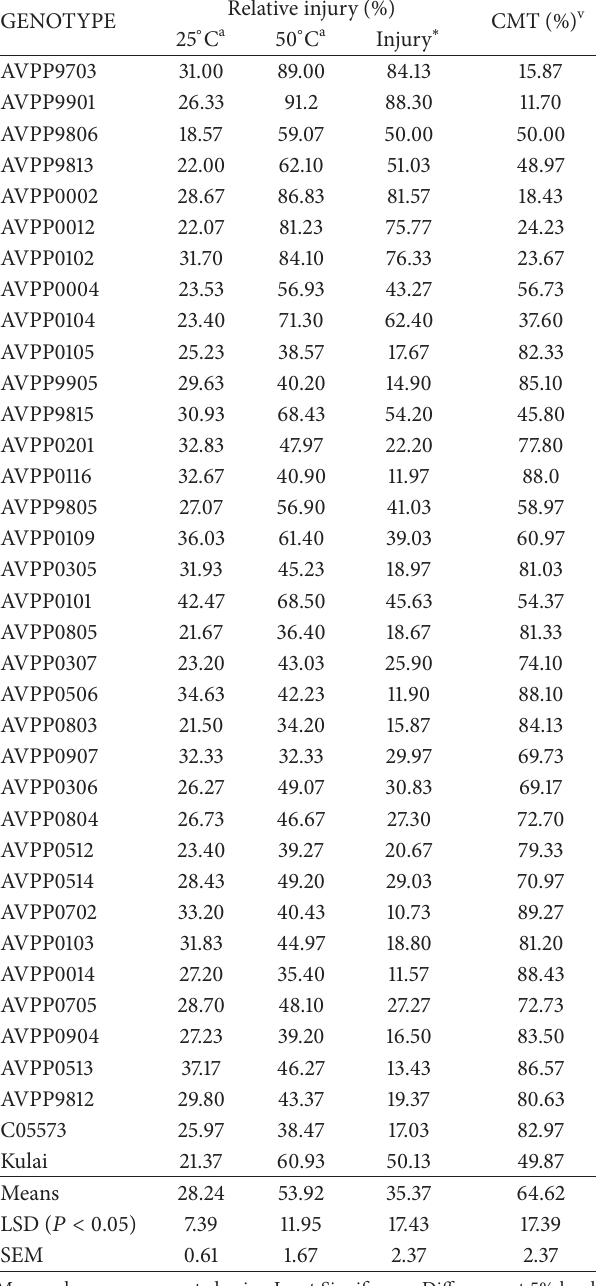
Table3:Relativeinjuryasdeterminedbycellmembranethermosta- bility test at 25 and 50 ∘ C for 20 min for 36 genotypes of Capsicum spp .